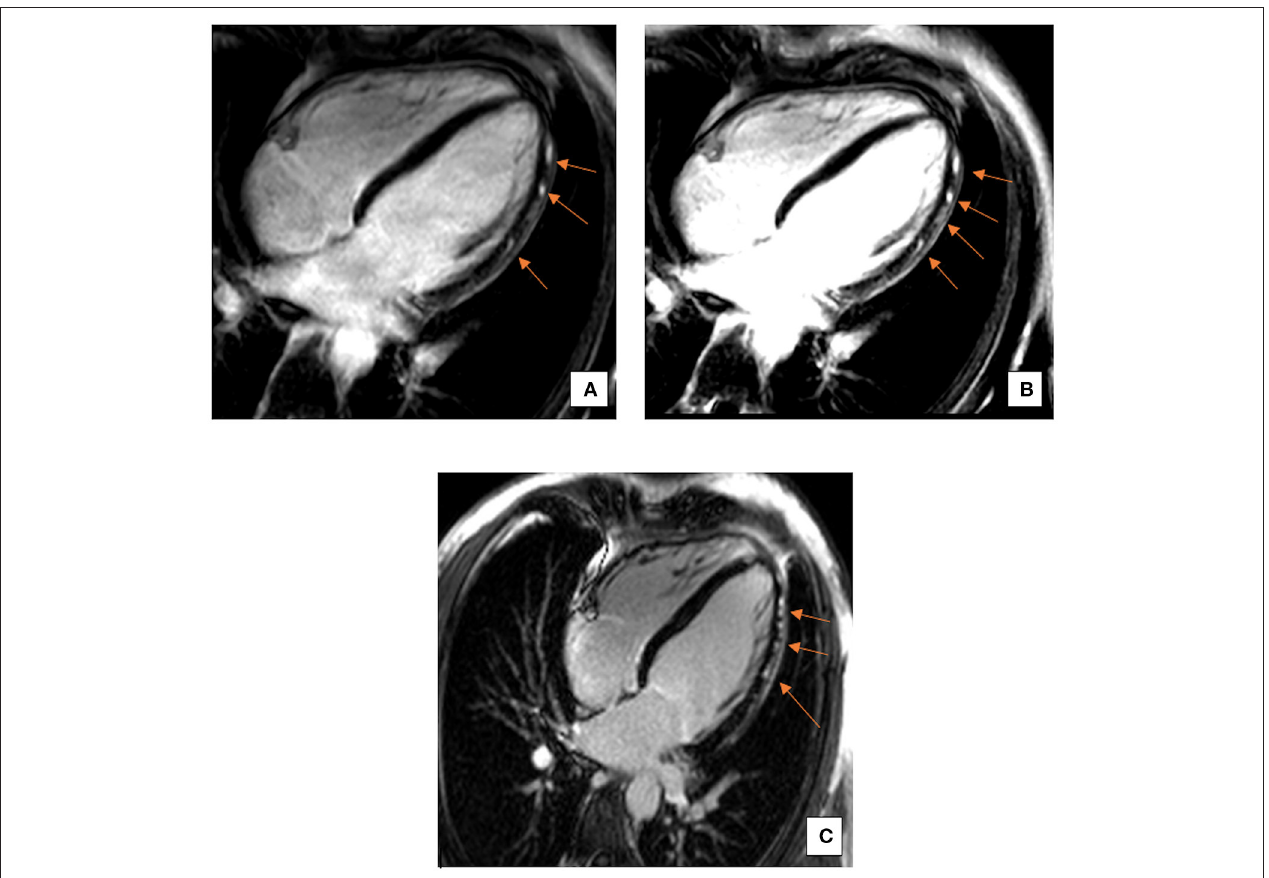
FIGURE 1 | Representative 4-Chamber (4CH) view images of late gadolinium enhancement (LGE). A comparison between LGE images from the past bout of myocarditis (A,B) and the current acute phase (C) . LGE is comparable and restricted to the subepicardial regions, particularly in the inferolateral and apical myocardial segments. Arrows indicate areas of